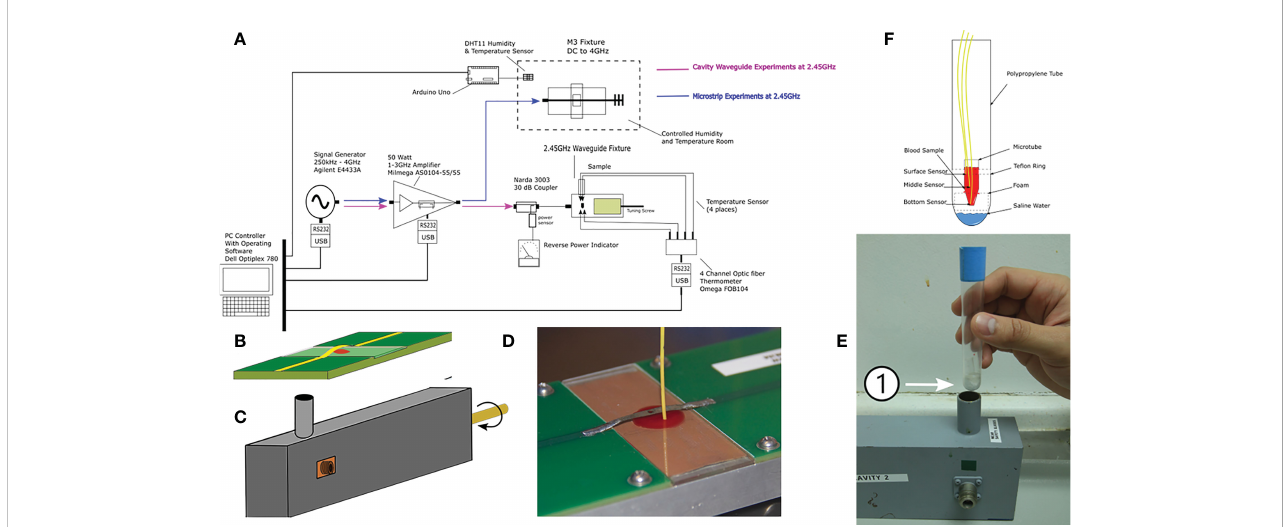
FIGURE 1 Microwave exposure system and their components. (A) Block diagram of all parts integrating the G and M3 microwave applicator systems (experiments were conducted separately); (B) M3 and (C) WG applicator device drawings. (D) Placement of the sample positioned under the metallic strip on a glass slide with a laser-milled cavity and the thermometer probe in the M3 (E) Test tube that holds inside the microtube that will carry the sample during microwave exposure inside the WG; the number 1 shows the microfuge (F) Drawing of the sample holders for the WG with the three thermometer probes placed at different depths of the sample. Dimensions are not to